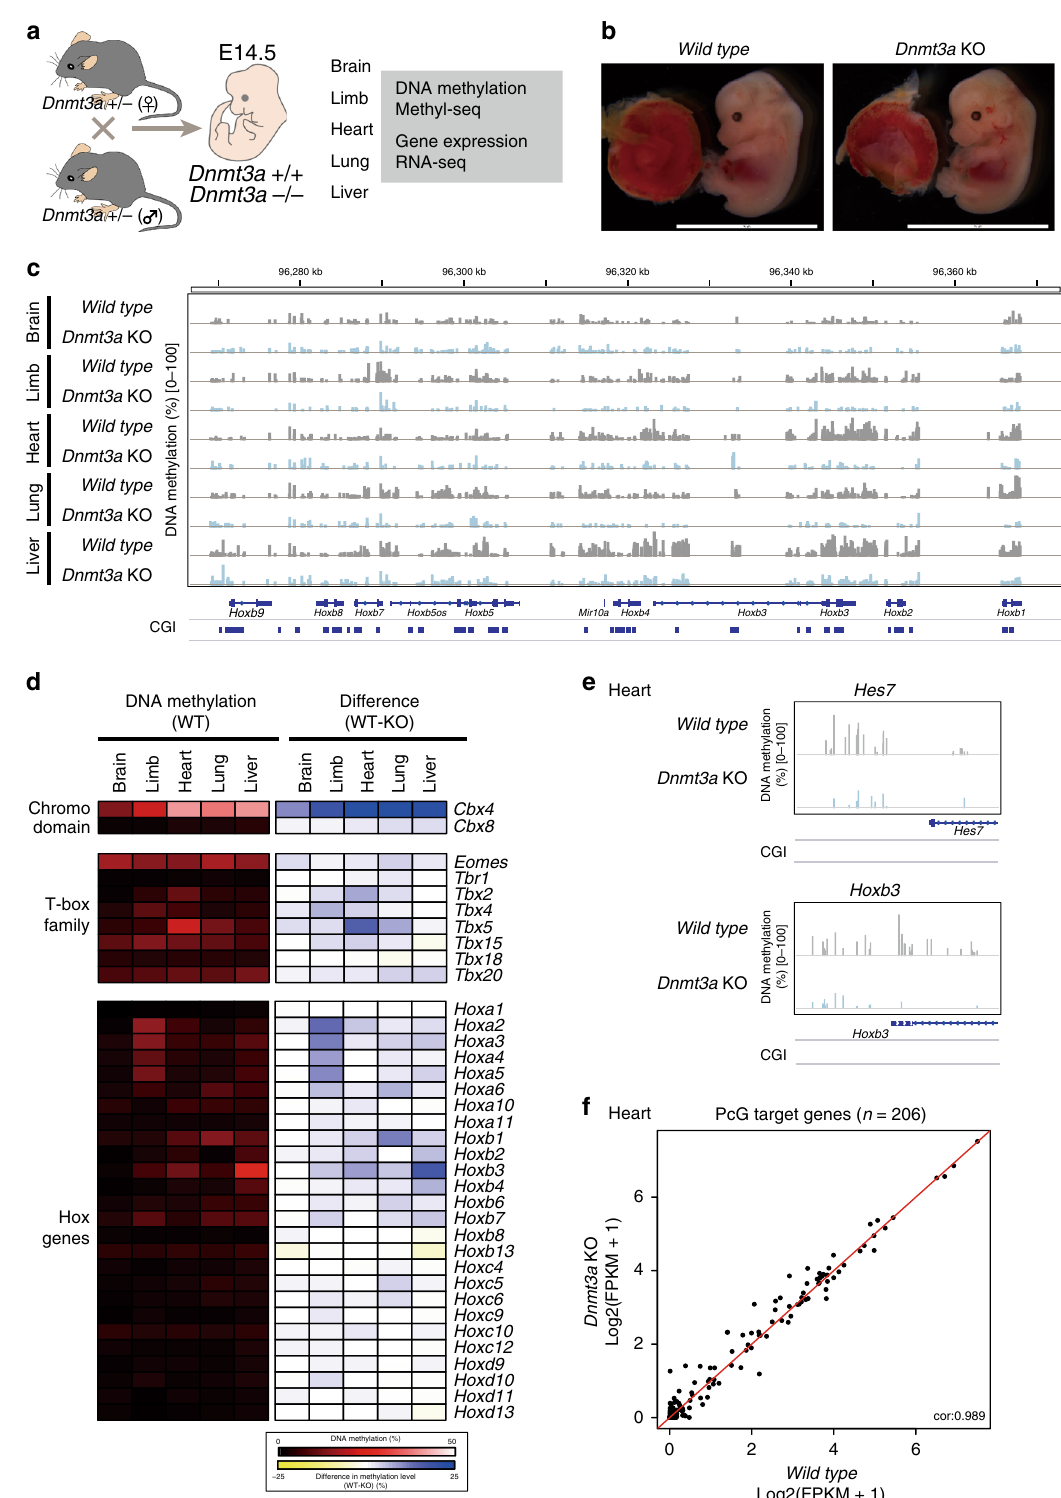
mutant AML (R882: major mutation) relative to DNMT3A WT AML, suggesting that inactivating DNMT3A mutation causes defects in epigenetic repression of PcG target developmental genes (Fig. 6c, d). These results are also consistent with those of a recent study demonstrating that a gain-of-function mutation at DNMT3A causes microcephalic dwar fi sm and hypermethylation of PcG-regulated genes 31 . Collectively, these data suggest that the